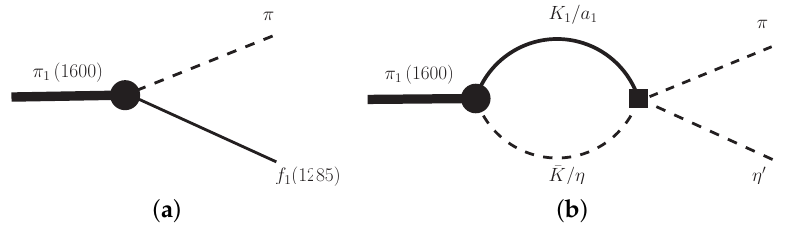
f 1 ( 1285 ) π reaction, and ( b ) the π 1 ( 1600 ) → → η (cid:48) π transition amplitudes at →